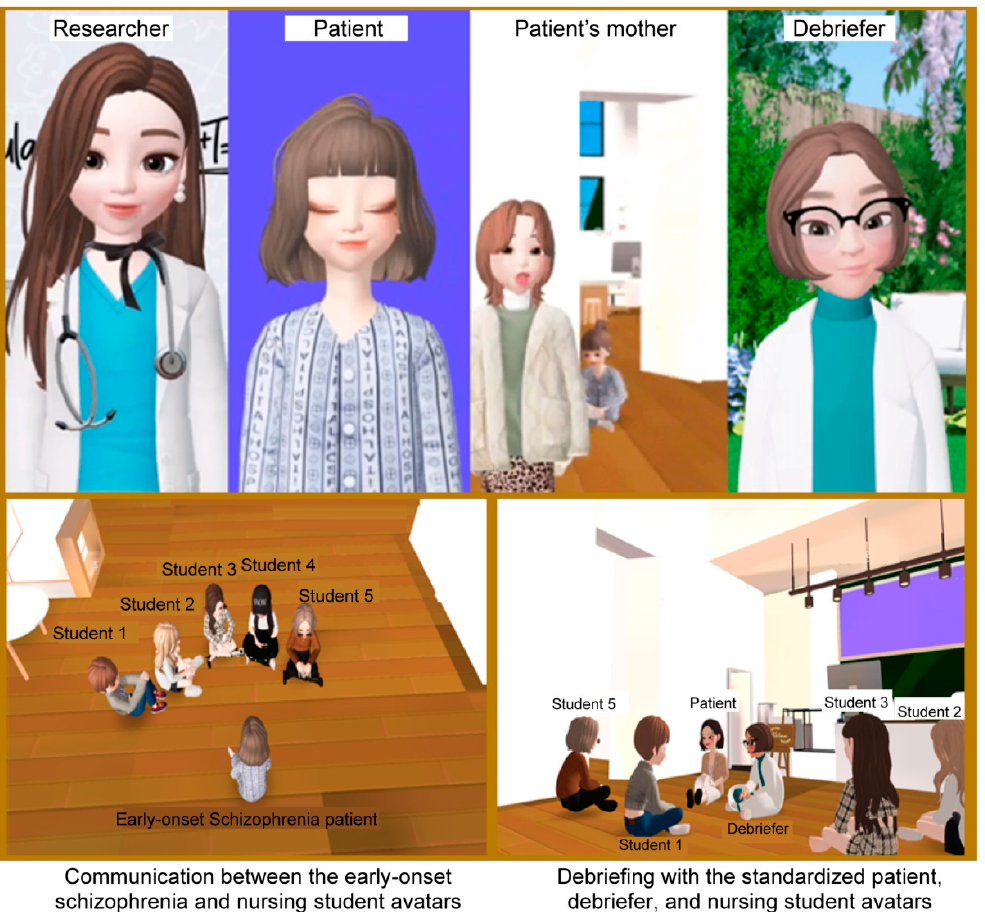
Figure 2. Screenshot of the early onset schizophrenia nursing simulation program in the metaverse (Zepeto ® World).